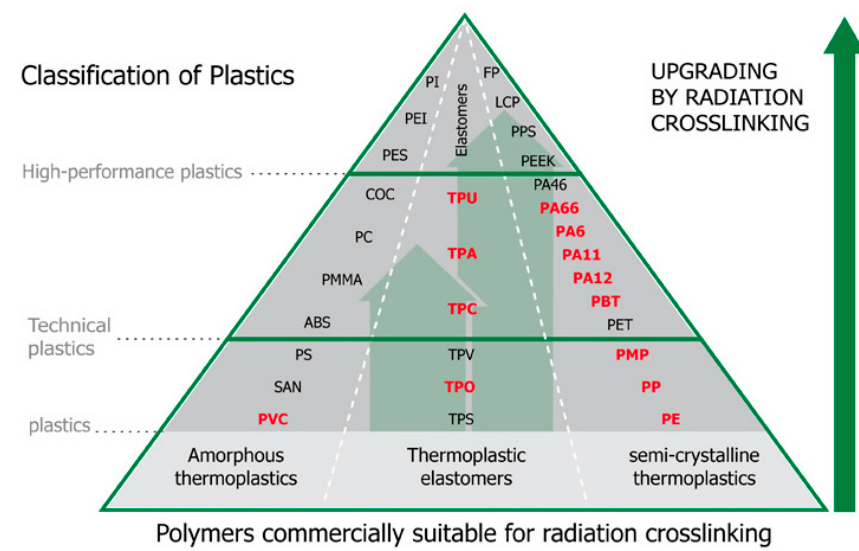
Figure 2. Influence of radiation crosslinking on plastics [24,25].